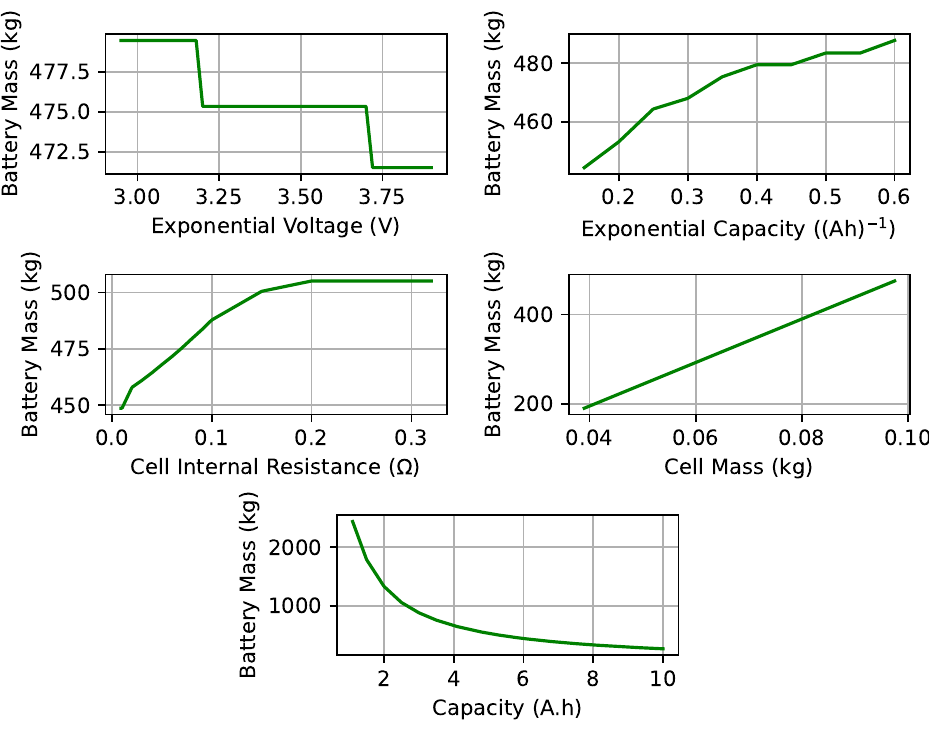
Figure 7. Sensitivity analysis of exponential voltage ( top-left ), exponential capacity ( top-right ), internal resistance ( mid-left ), weight of the cell ( mid-right ) and capacity ( bottom